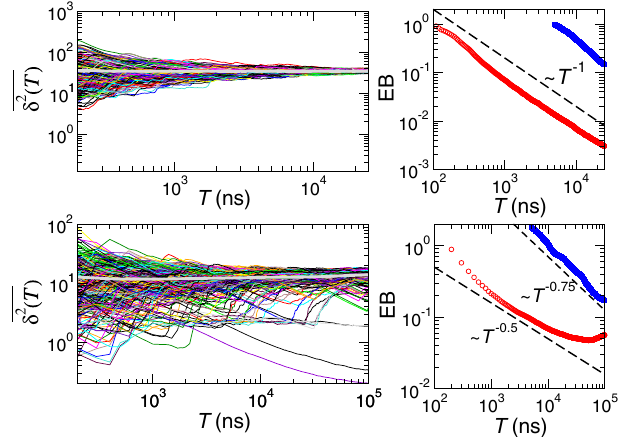
FIG. 8. Spatiotemporal fluctuations of the lipid diffusion in noncrowded (top) and crowded (bottom) DPPC membranes. (Left) Individual time-averaged MSD curves are plotted as a function of measurement time T at fixed Δ ¼ 100 ns. The thick gray lines represent the mean time-averaged MSD h δ 2 ð T Þi . (Right) Ergodicity breaking parameter EB ð T Þ , Eq. (7), depicted for Δ ¼ 100 ns (red circle) and 5000 ns (blue squares).